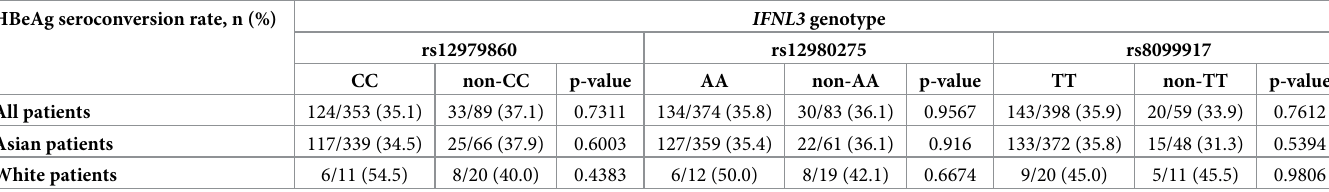
Table 2. Rates of HBeAg seroconversion in HBeAg-positive patients according to genotype at rs12980275, rs12979860, and rs8099917. Some patients did not have data available for all genotypes, and percentages are calculated on the basis of the number of patients with data. HBeAg seroconversion rate, n (%)